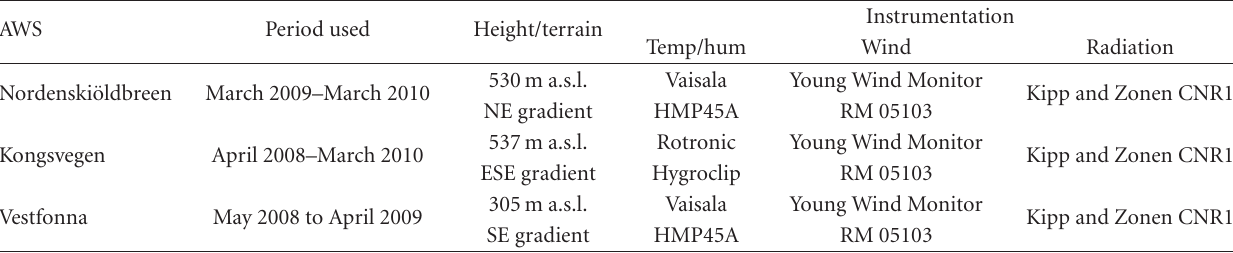
Table 1: AWS site details with